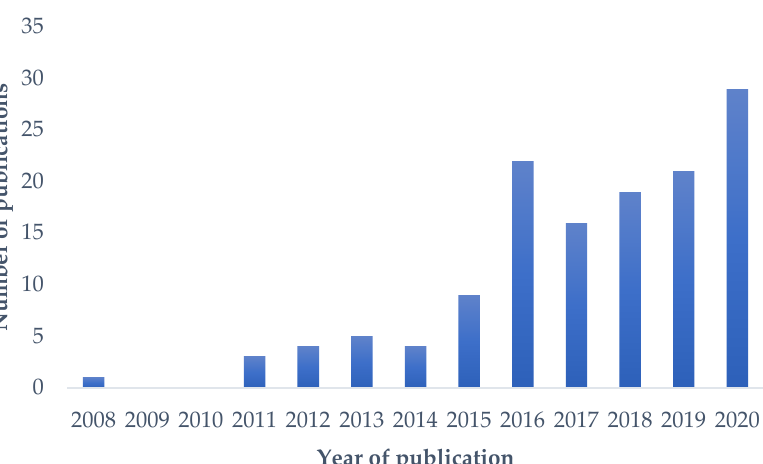
Figure 2. Numberofpapers(WebofScience ® )publishedperyearonthetopicsofmetforminand Figure 2. Number of papers (Web of Science ® ) published per year on the topics of metformin and metabolomics.